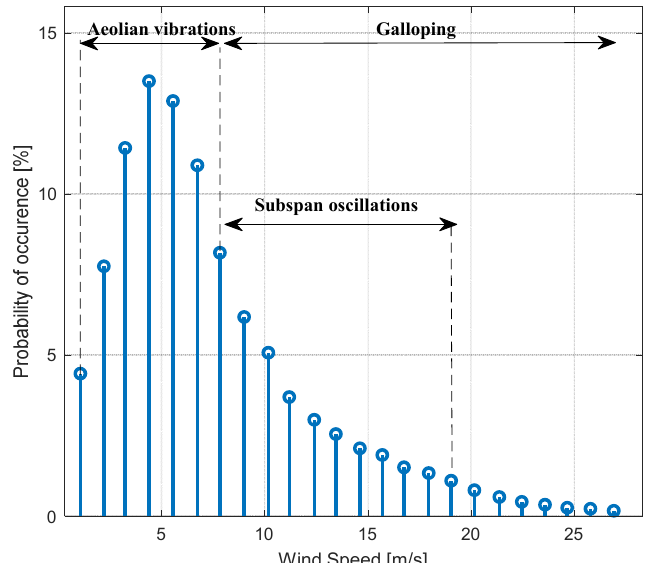
Figure 10. Probability of occurrence of the different mechanisms as a function of the wind speed.